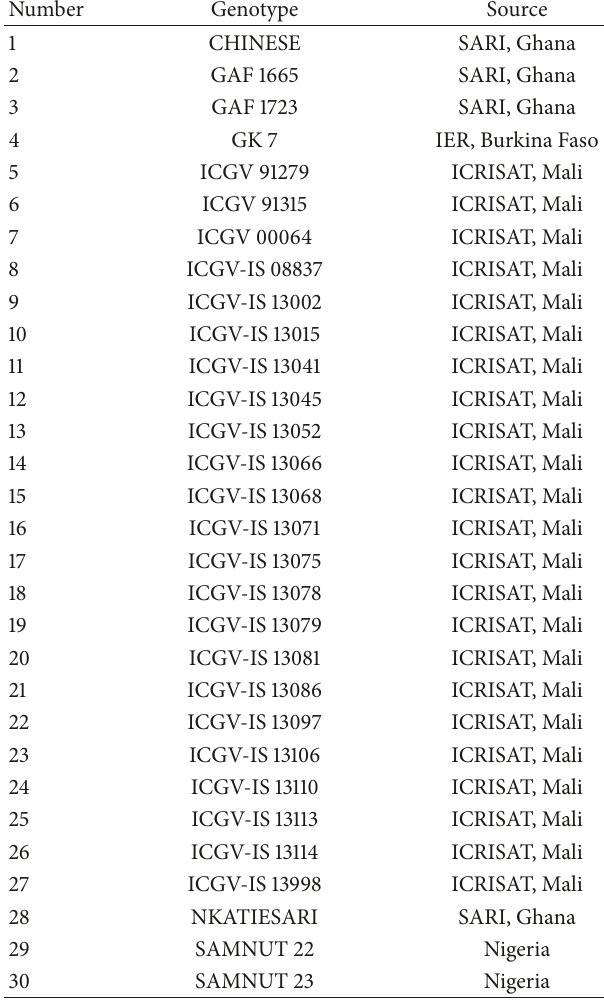
Table 1: List of genotypes evaluated on-station at Nyankpala in the 2015 cropping